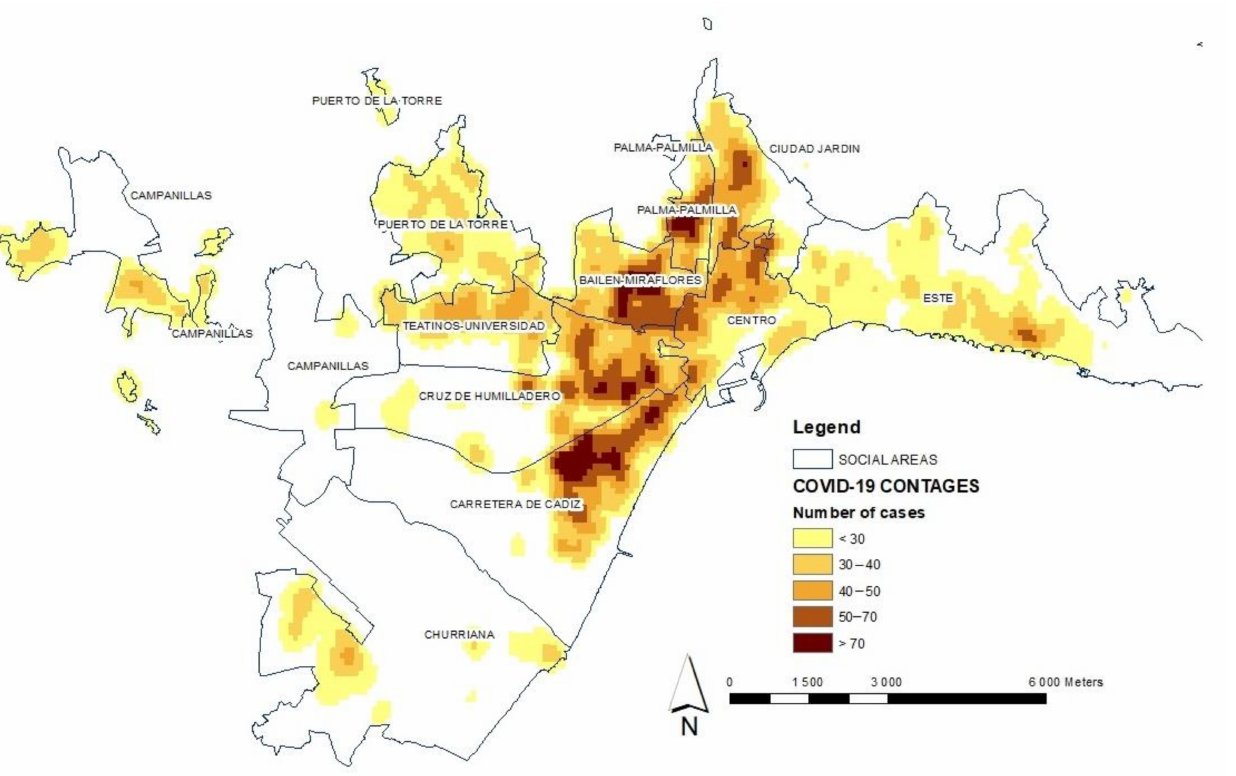
Figure 4. Analysis of the distribution of total infections by COVID-19 in the social areas of the city of Malaga during the period from 5 March 2020 to 31 March 2021. The behavior of the pandemic is observed through the cases of contagion in the districts of the city. Source: Author’s elaboration based on data from the Technical Subdirectorate of Information Management of the Andalusian Health Service (SAS), Regional